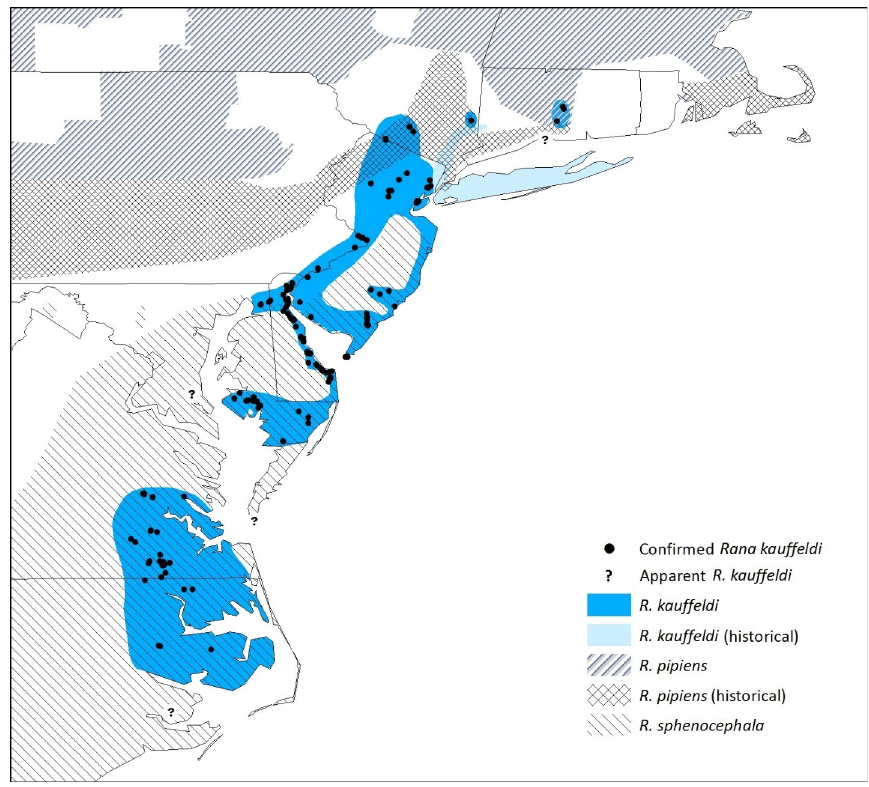
Fig 3. Range of Rana kauffeldi , with presence points confirmed by bioacoustics or genetics, compared to ranges of R . pipiens and R . sphenocephala . Historical ranges for R . kauffeldi and R . pipiens are based on examination of museum specimens and recent detections. Question marks denote locations where museum specimens appear to be R . kauffeldi but no bioacoustic or genetic evidence is available, or where genetic determinations were questionable.